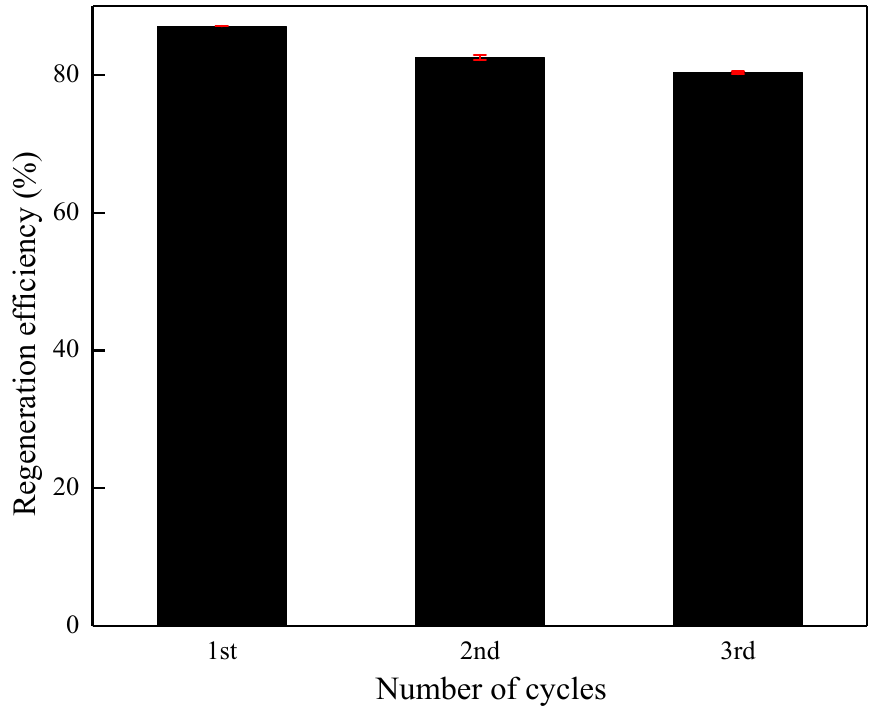
Figure 8. Reusability of DA/ β -CD, 0.2 g adsorbent in 50 mL of DPA solution (100 ppm) at room temperature.